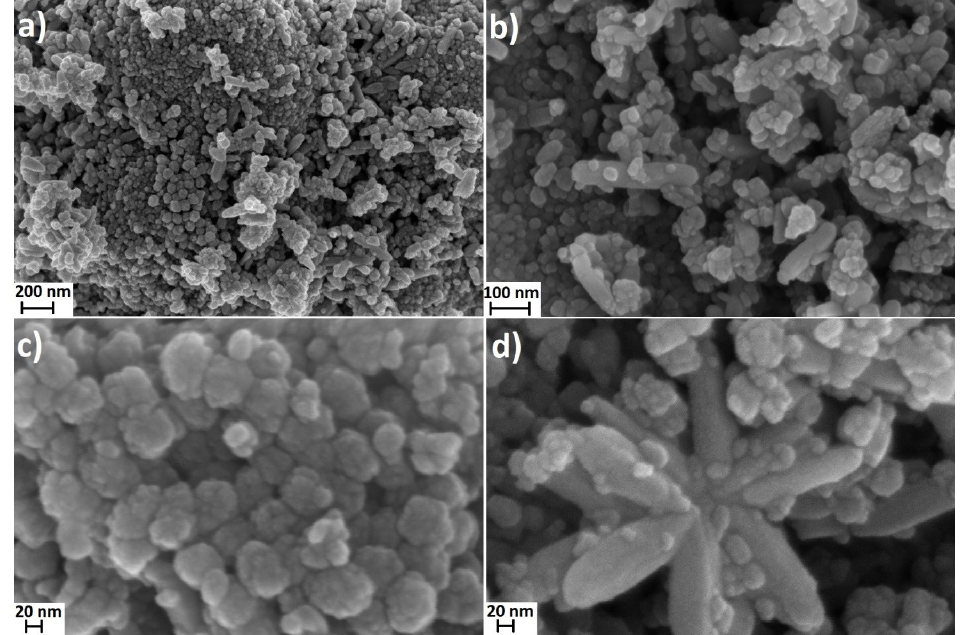
Figure 2. SEM images of NPs: ( a – d ) TiO 2 .